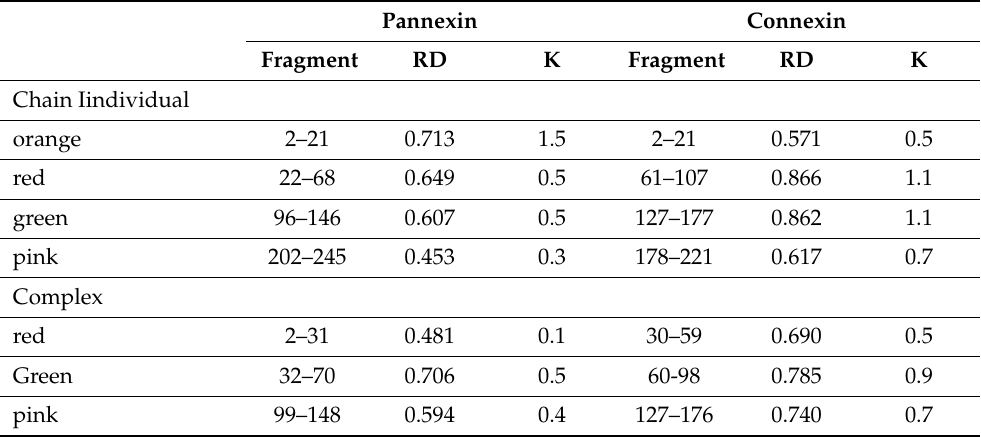
Table 2. Comparison of RD and K values for analogous sections determined on the basis of similarity of Figure 5. D Gauss function spanned on a single chain) and on the basis of T profiles for chains representing complexes (all chains in the complex represent the same status). 3D Gauss function spanning the entire complex. Pannexin Connexin